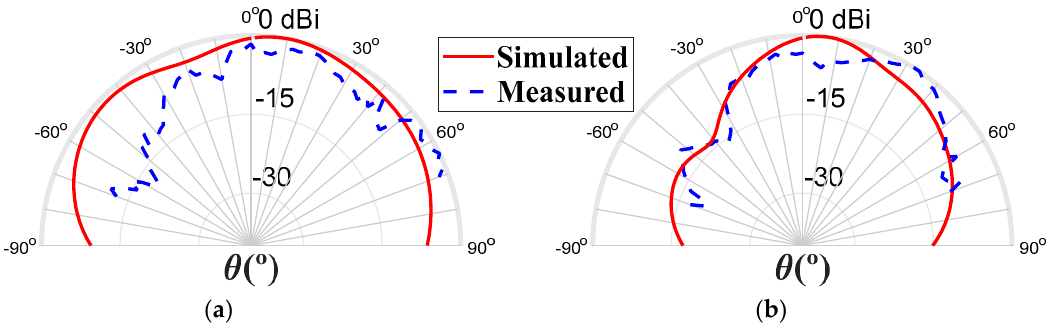
Figure 16. Radiation pattern to 20 GHz, ( a ) plane φ =90 ⁰ , and ( b ) plane φ =0 ⁰ .